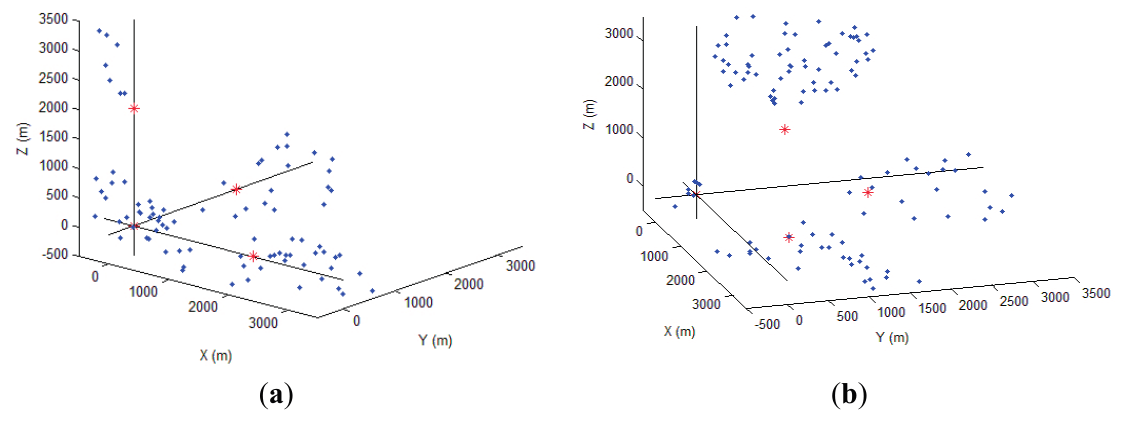
Figure 9. Blind areas: ( a ) scenario 1 and ( b ) scenario